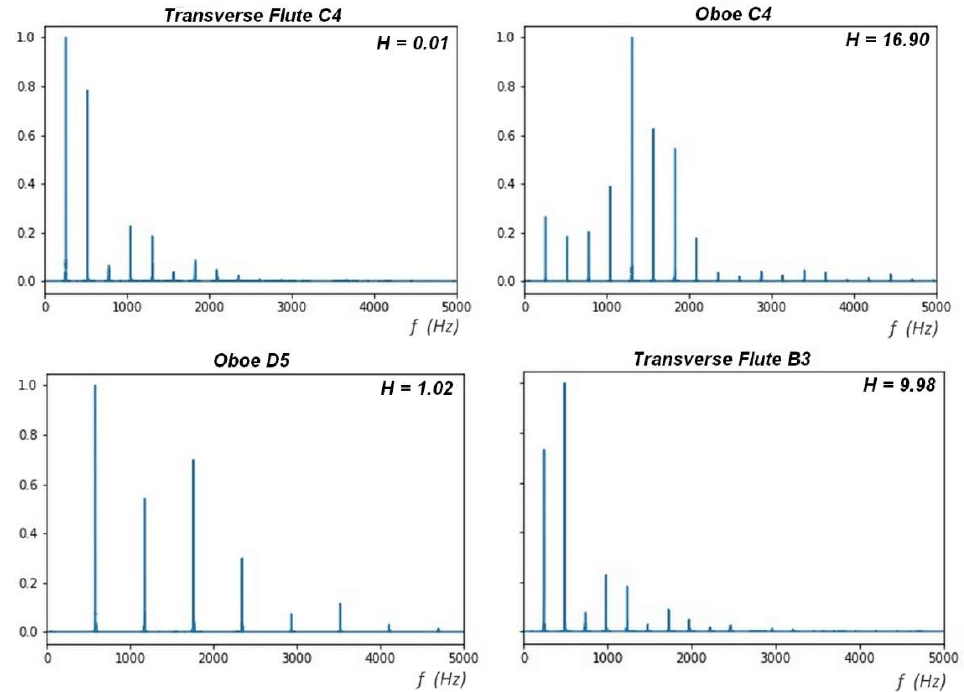
Figure 7. Comparison of Harmonicity H for different sounds and instruments. Top panel: C4 Flute and Oboe sound comparison. Lower panel comparison of different sounds for the same instrument (Left: Transverse Flute, right Oboe).